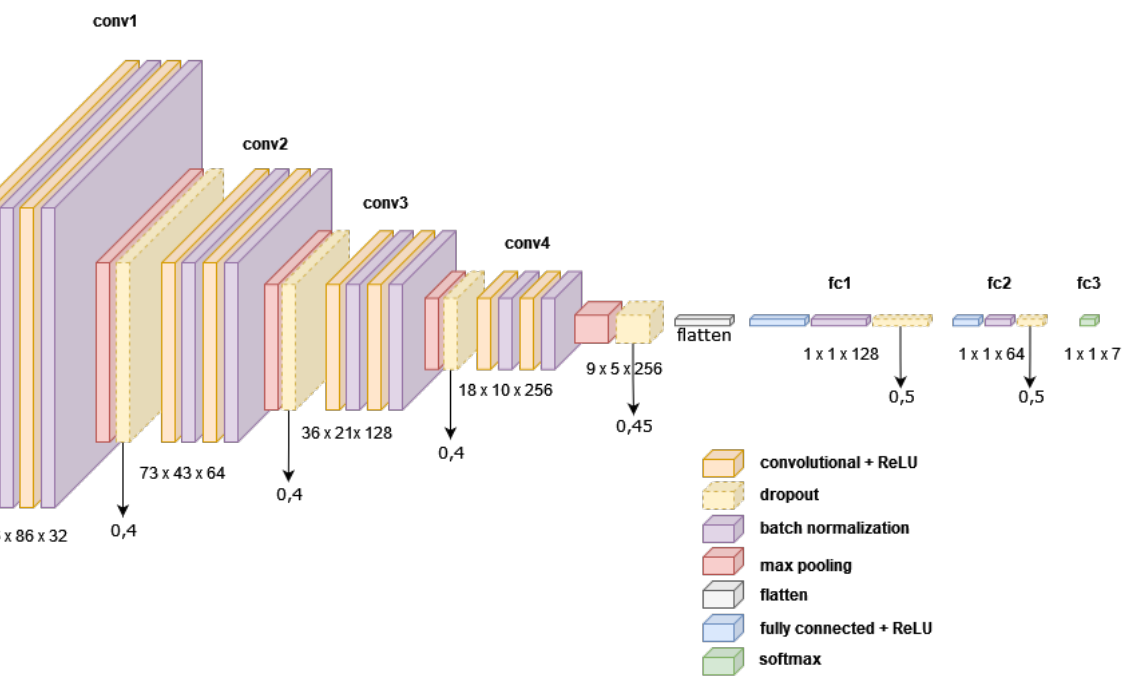
Figure 3. Architecture of the final CNN network used for ethnicity classification. Table 3. CNN architecture